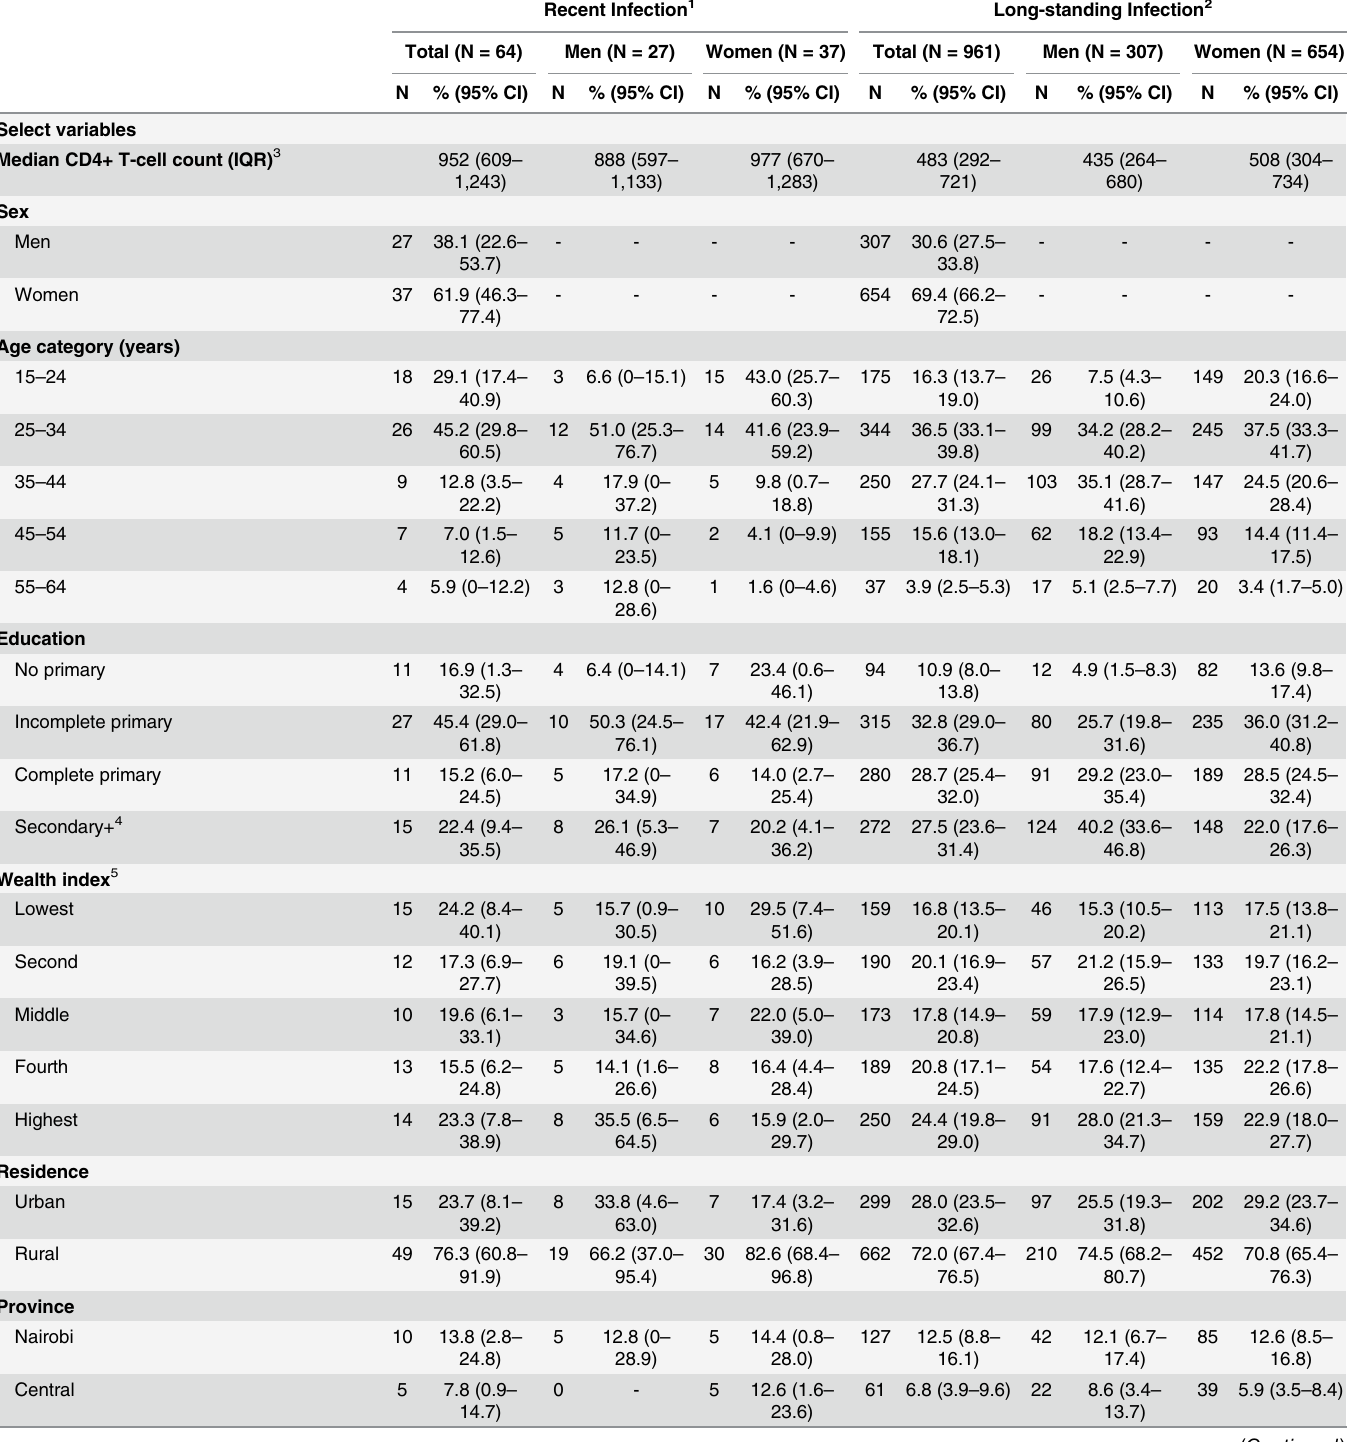
Table 1. Frequencies and weighted proportions of select demographic, behavioral, and biologic variables among HIV-infected women and men aged 15 – 64 years by recent and long-standing infection status, 2007 Kenya AIDS Indicator